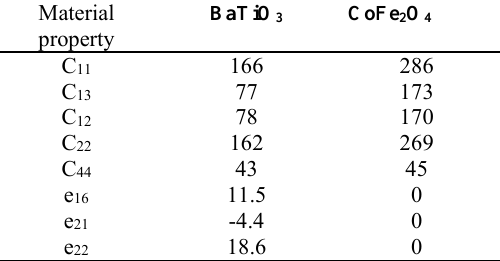
Table 1: Piezo-electric and piezo-magnetic material